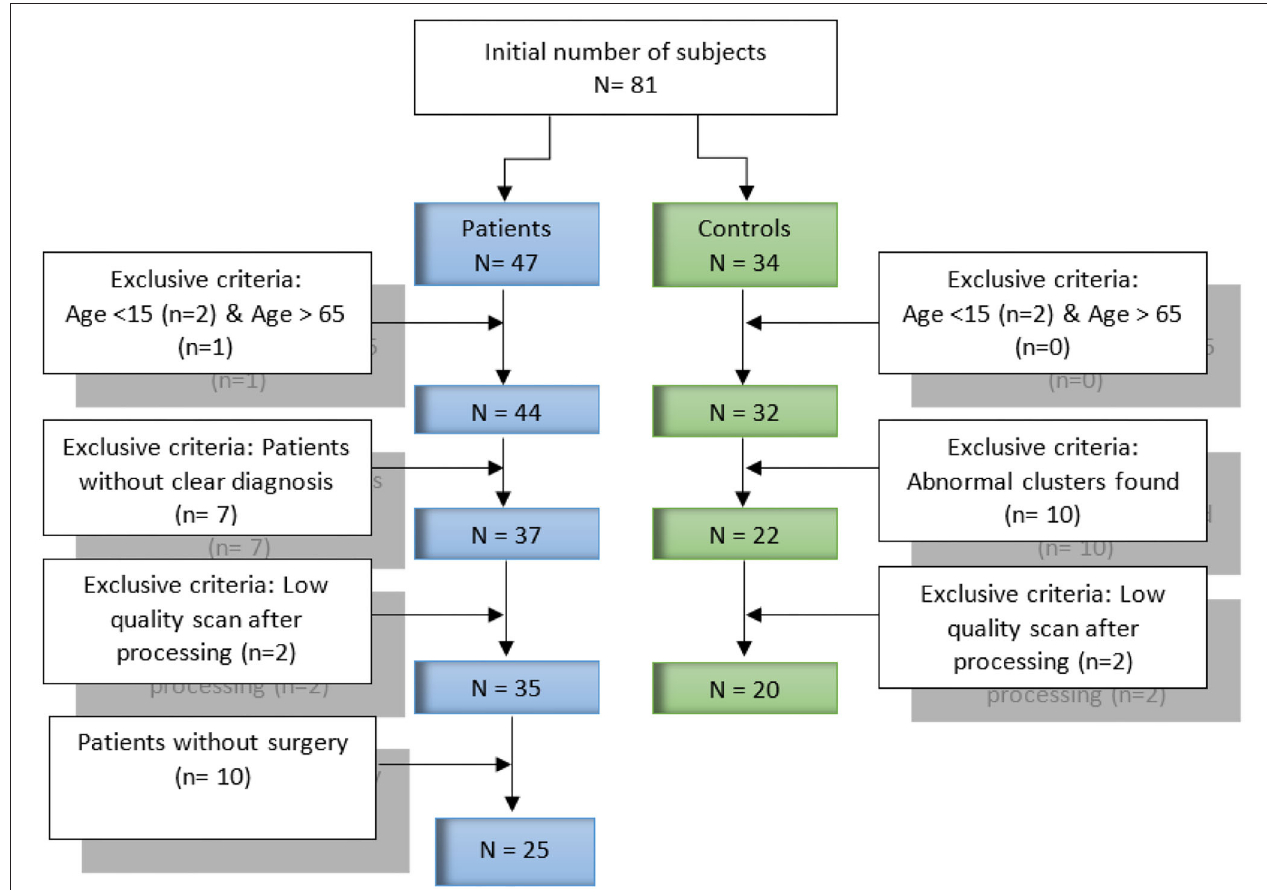
FIGURE 1 | Criteria and candidate selection procedure.